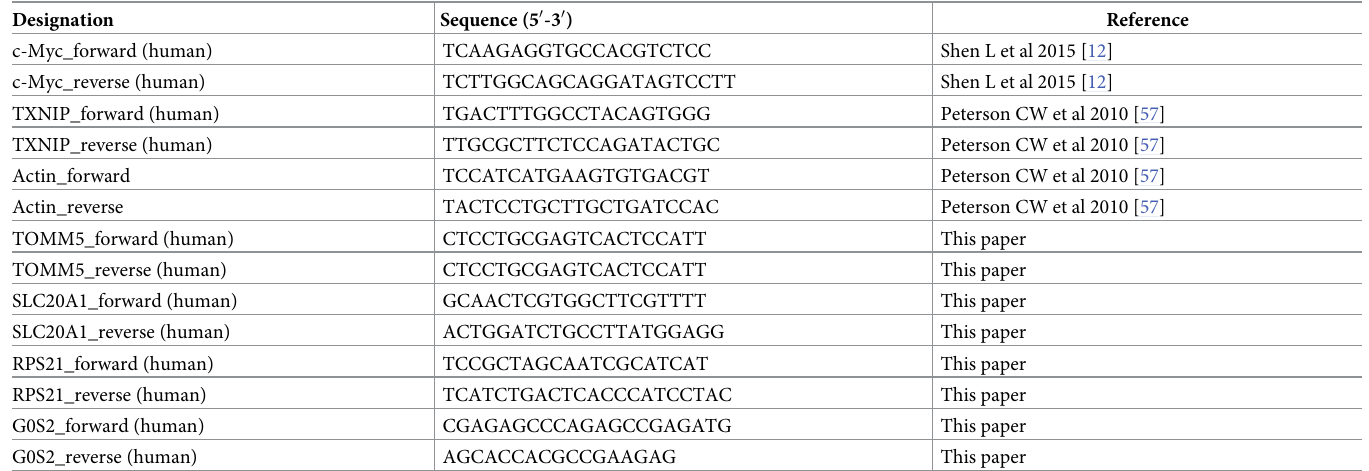
Table 1. List of qRT-qPCR